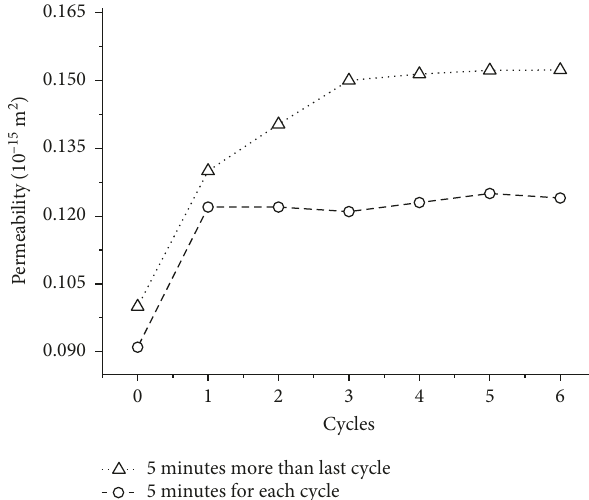
Figure 5: Changes in permeability with freeze-thaw cycles of liquid nitrogen.